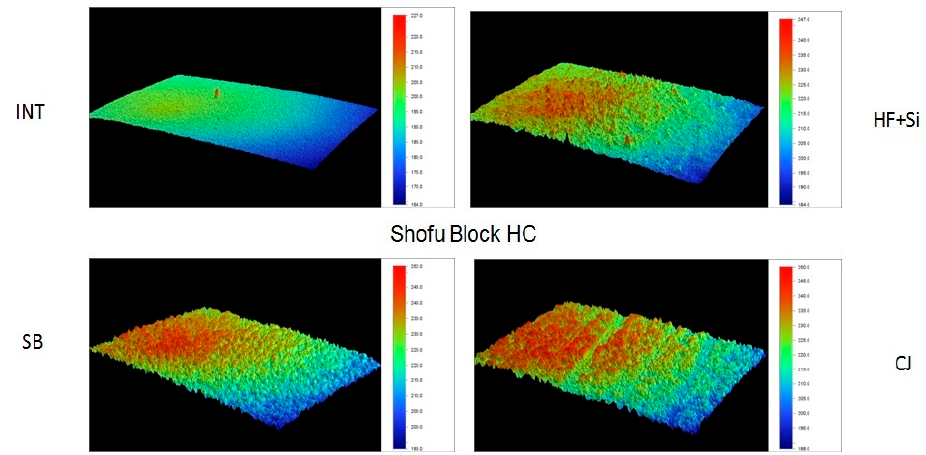
Figure 3 Representative 3D topographic surface maps of Shofu Block HC (×20 magnification).